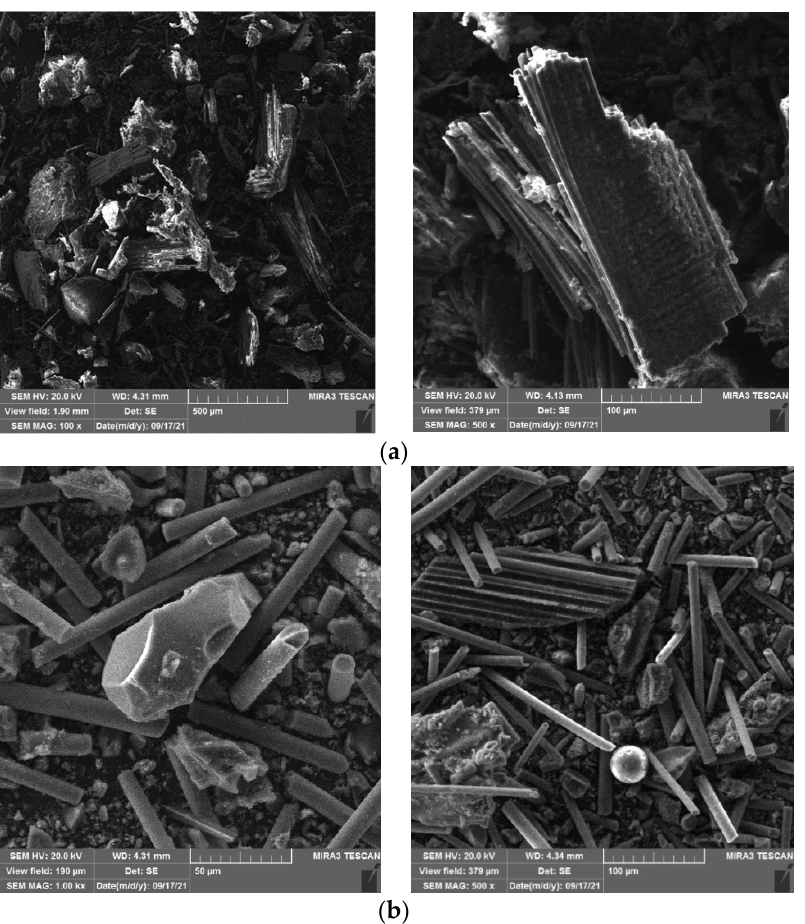
Figure 5. ( a ) NC2—dust from mechanical treatment before vacuum pyrolysis, and ( b ) NC2—dust from mechanical treatment after vacuum pyrolysis, at different magnifications.